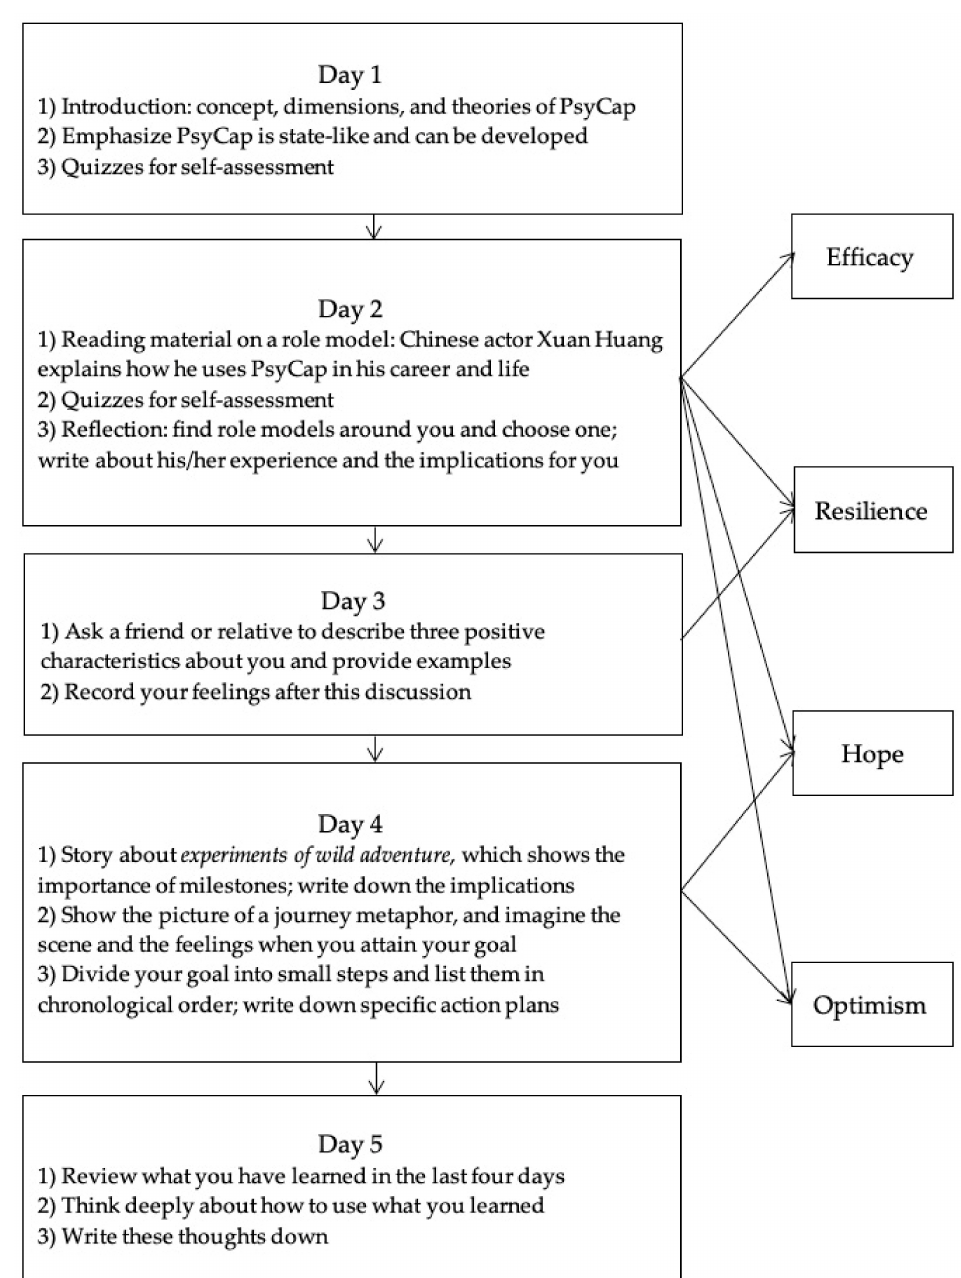
Figure 2. The intervention